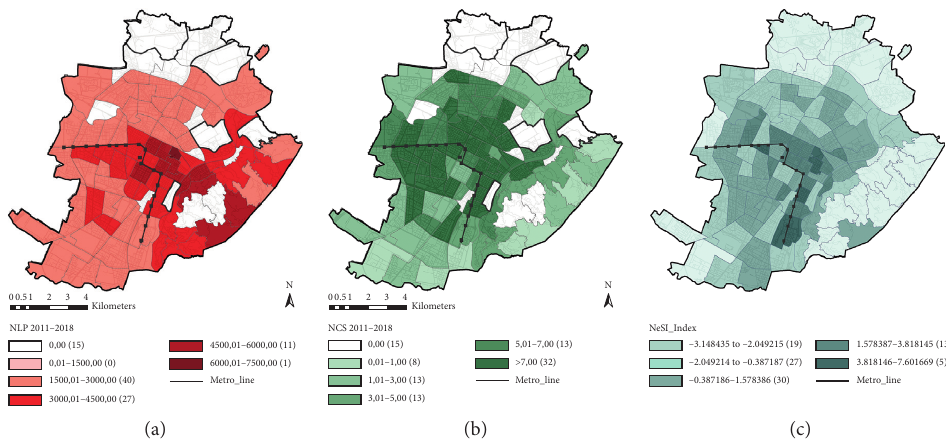
Figure 8: (a) Listing prices of new housing stock (NLP). (b) Construction Sites Density (CSD). (c) NeSI Mean values (source: author’s